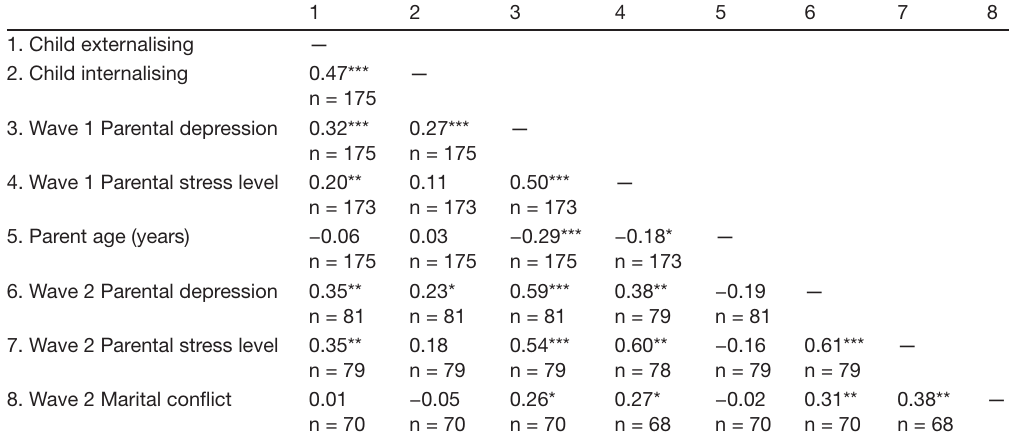
Table 3. Bivariate